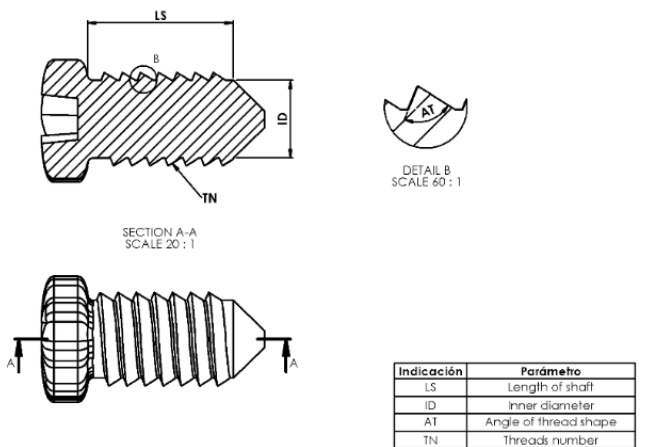
Figure 2. Selected parameters of mini screw for DOE arrangement.